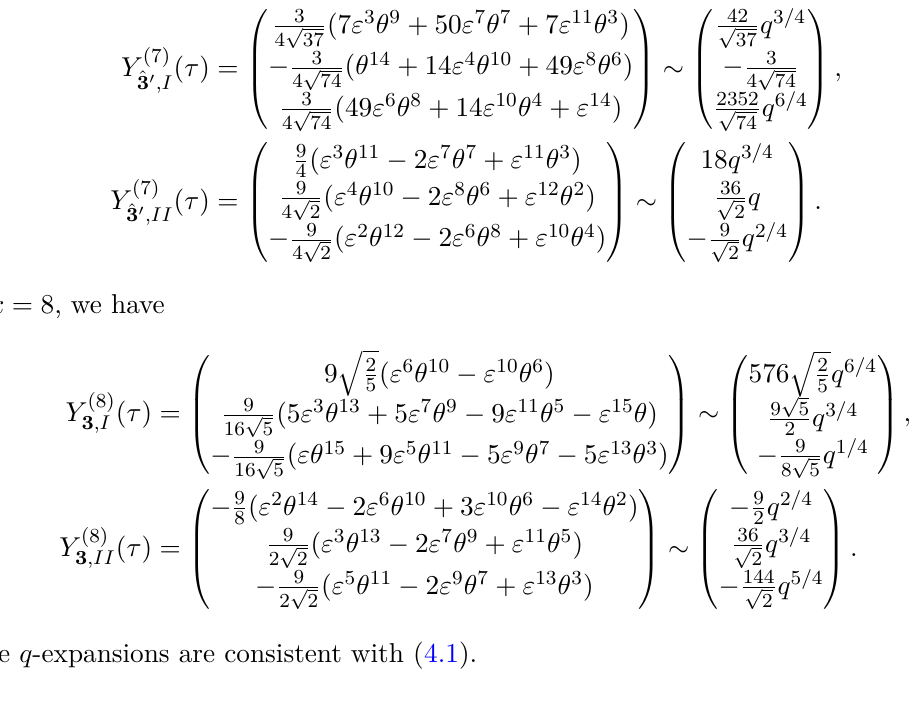
Table 10. The matrix representations of the generators of Γ 0 modular forms of 3-dimensional representations, and omit the other representations in this table. Our notation is based on